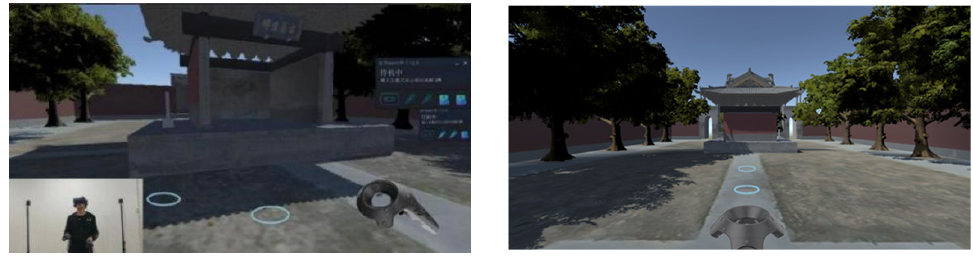
Figure 10. A VR interaction experience with Houtu Temple Stage.